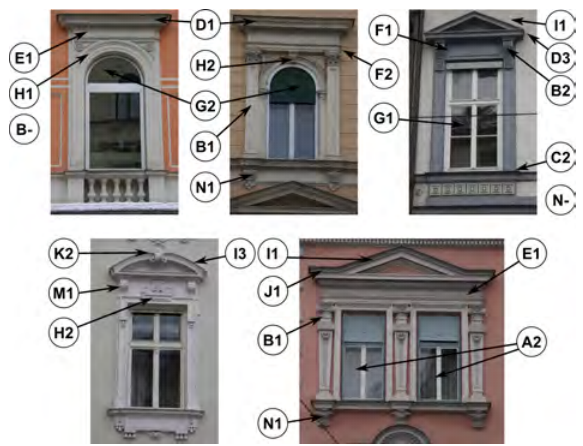
Figure 3: Various fact labels applied to five example windows. Refer to Table 1 and to Section 3.2 for explanations of the labels.